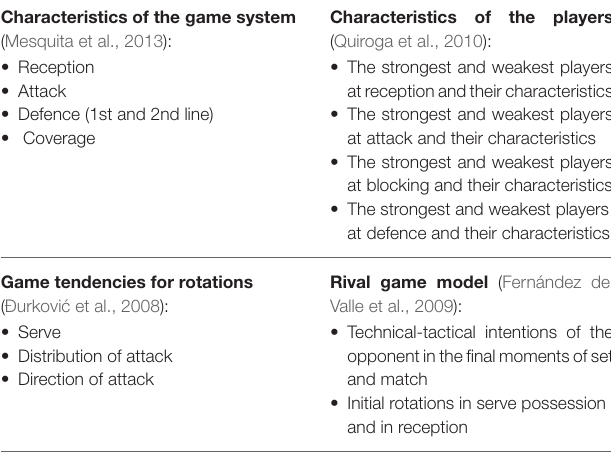
TABLE 2 | Aspects of the game considered for the opponent team